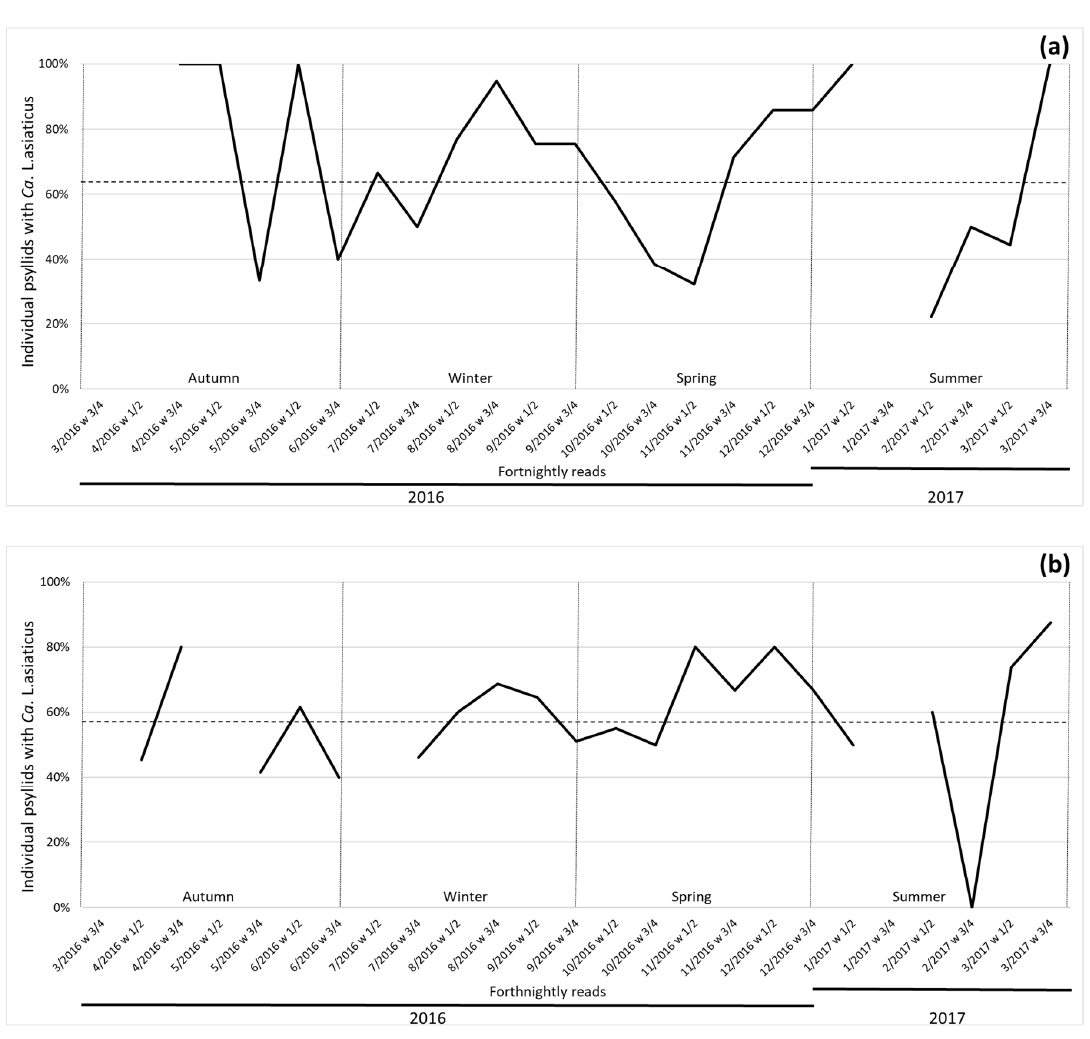
Figure 4. Percentage of psyllids carrying Candidatus Liberibacter asiaticus in fortnightly reads between March 2016 to March 2017. Dotted line indicates average for the farm (each time point is indicated with month/year numbering and week interval). Season indication was added to the image according to standard occurrence in southern hemisphere. ( a ) Iaras from the southwestern region of Avaré (two time points missing); ( b ) Gavião Peixoto from the central region in Araraquara (data up to February of 2016; three time points missing).